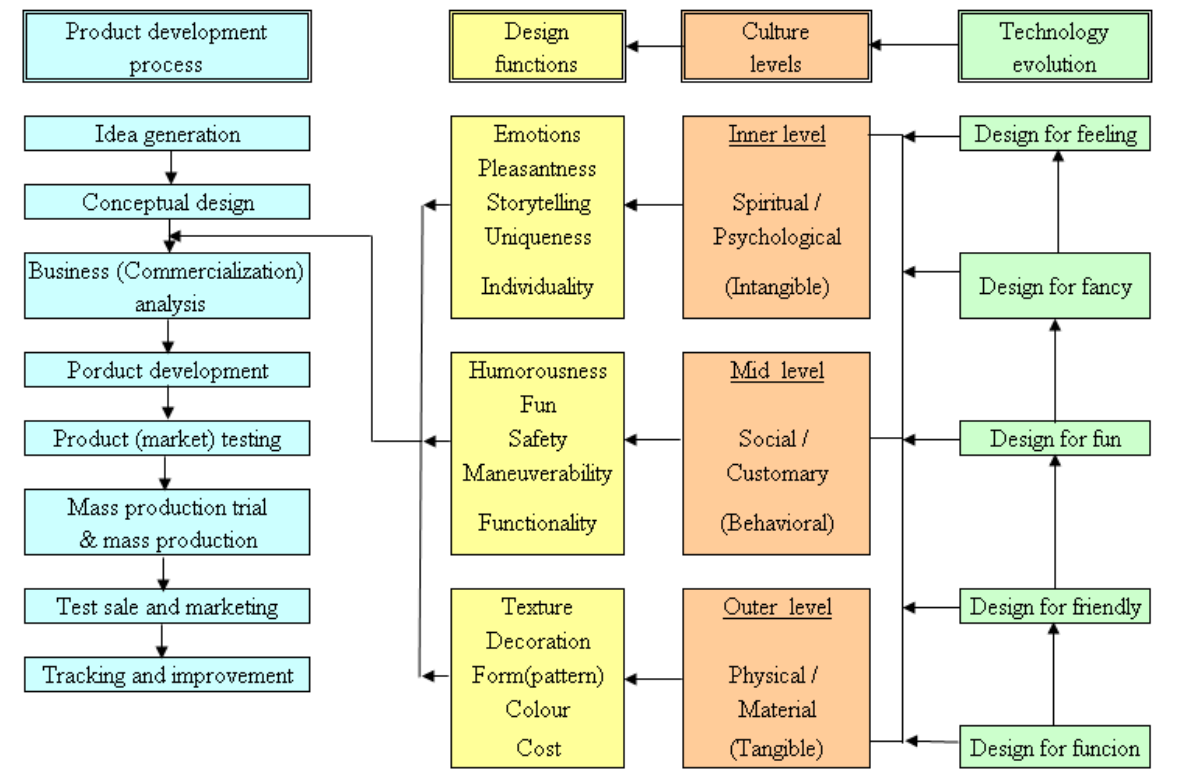
Figure 1. Diagram of the product design and development process based on a cultural creative product design model. (Source: [46,47]).